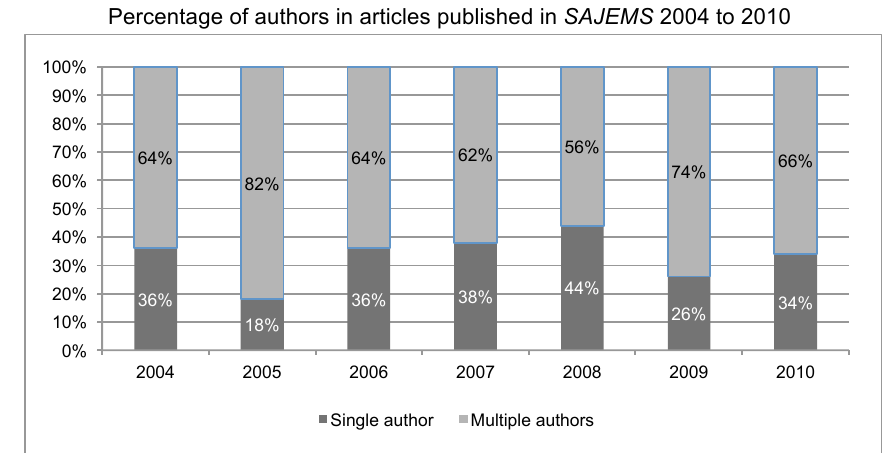
Percentage of authors in articles published in SAJEMS 2004 to